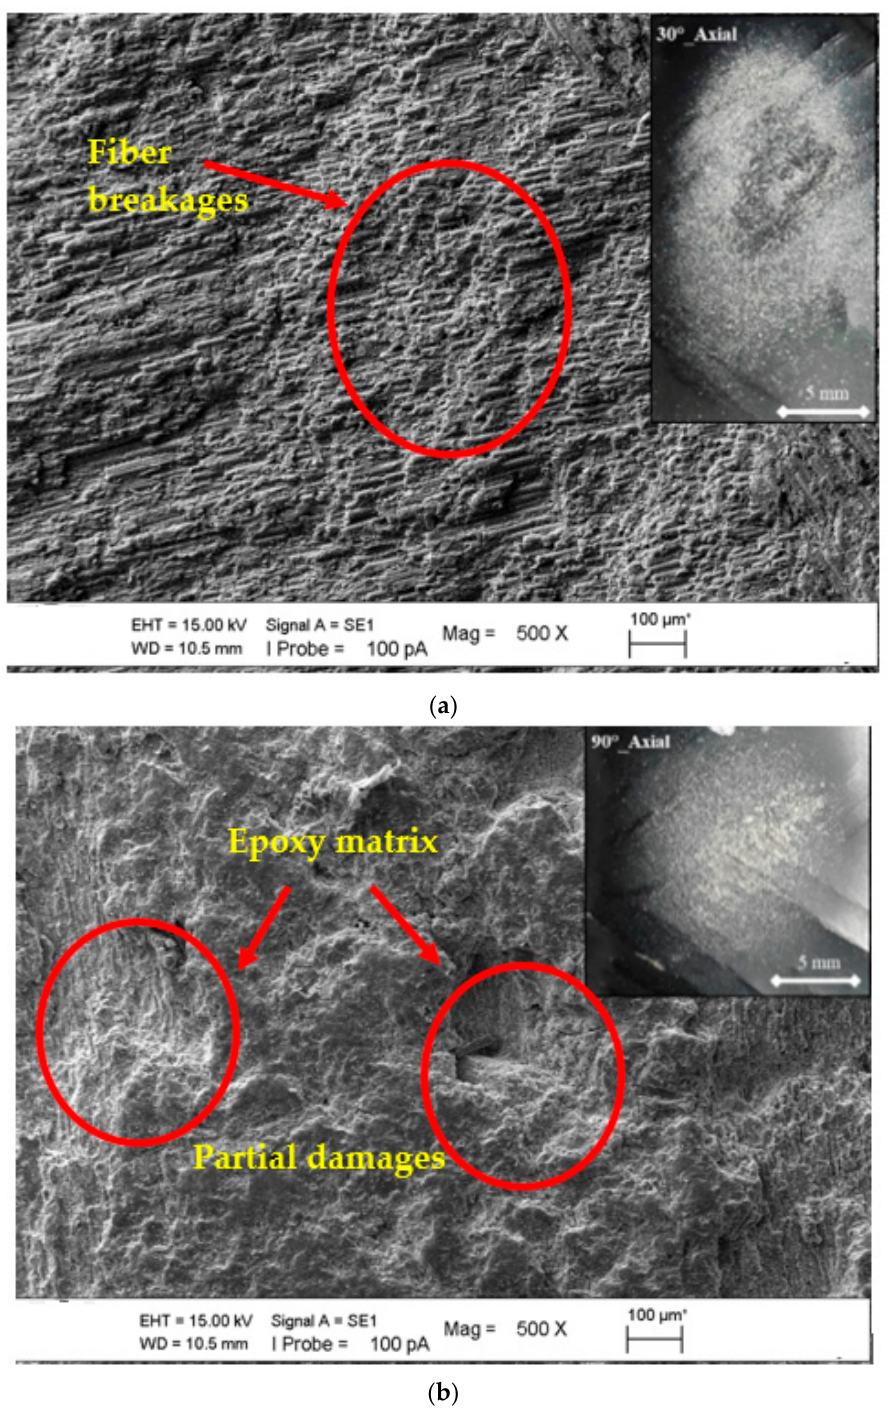
Figure 12. SEM images of matrix damages and fiber breakage on the surface at the axial orientation with the changing impingement angle: ( a ) 30° and ( b ) 90°.